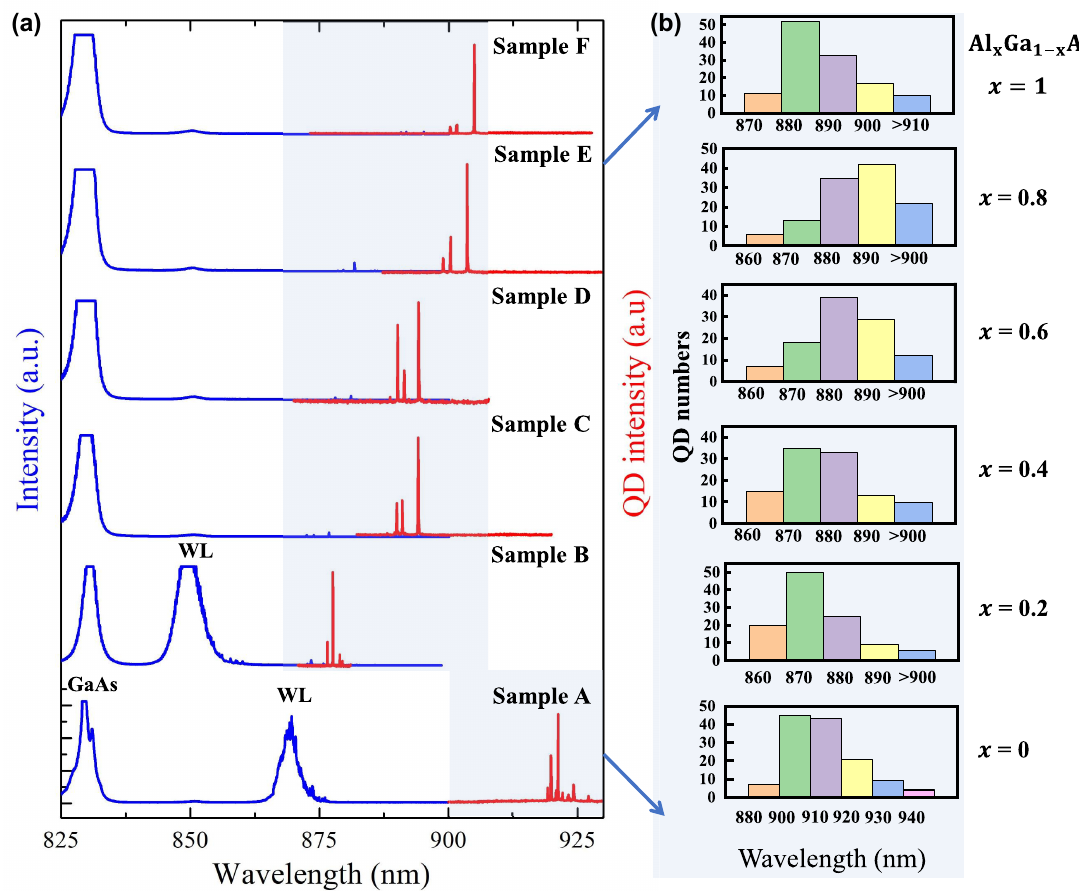
Figure 2: Optical properties of samples A – F. (a) Photoluminescence spectra of samples A – F with emission wavelength ranging from 825 – 930 nm (blue lines), corresponding representative PL spectra of Al x Ga 1 − x As-capped single QDs (red lines). (b) Wavelength distribution of about 100 single QDs of samples A –